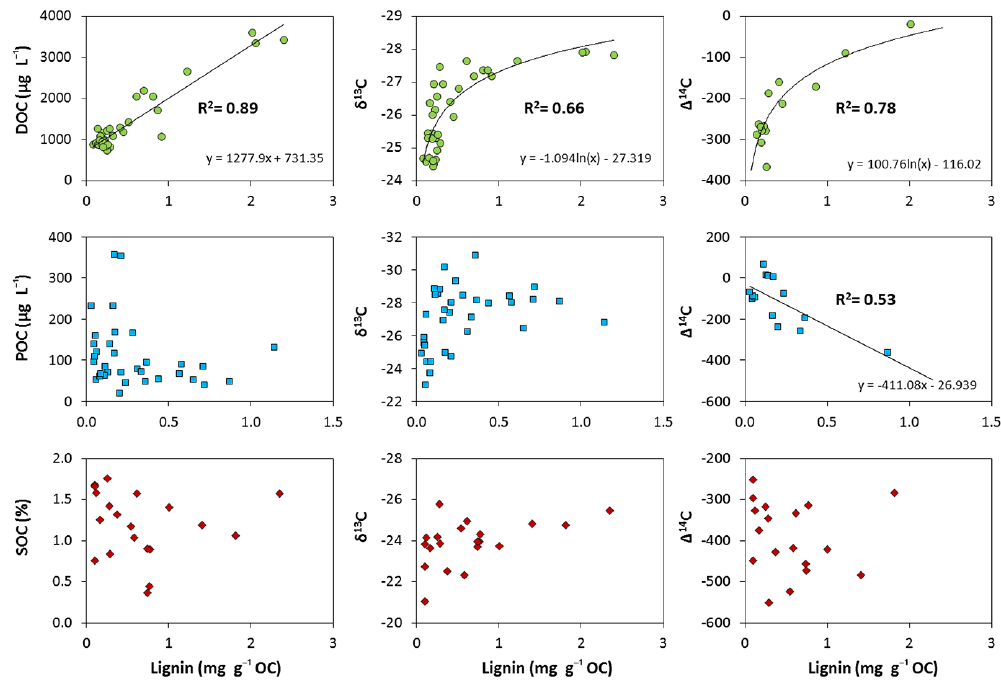
Figure 7. Correlations between lignin concentrations (mgg − 1 OC) and organic carbon, δ 13 C and (cid:49) 14 C signatures in DOC (green circles), POC (blue squares) and SOC (red